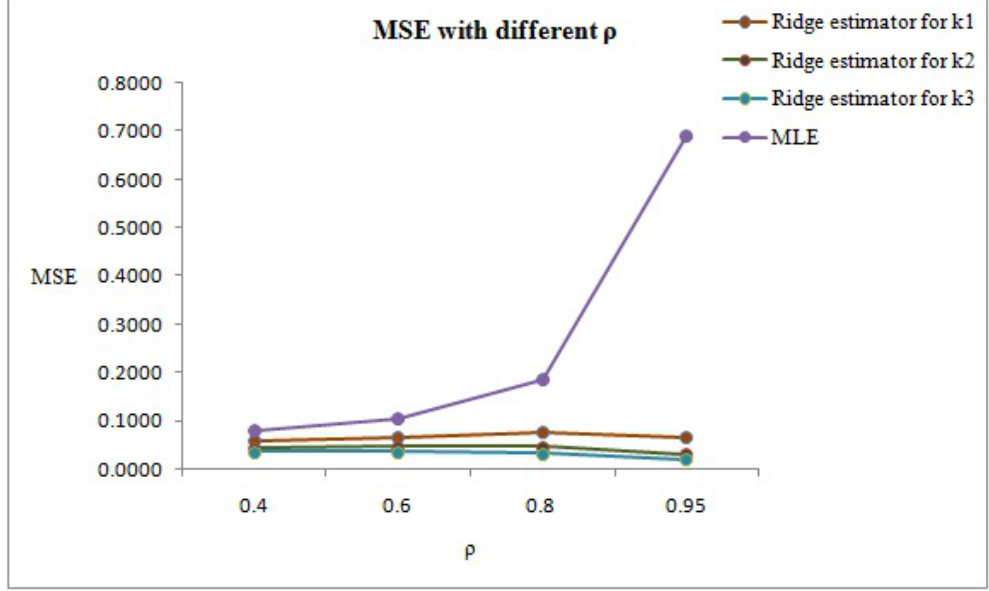
Figure 1. Comparison of MLE and ridge estimators of β in simulation study. Here, k1, k2 and k3 are ridge parameters such that; k1 = 1/ ˆ β (cid:48) ˆ β , k2 = q / ˆ β (cid:48) ˆ β and k3 = ( q + 1 ) / ˆ β (cid:48) ˆ β